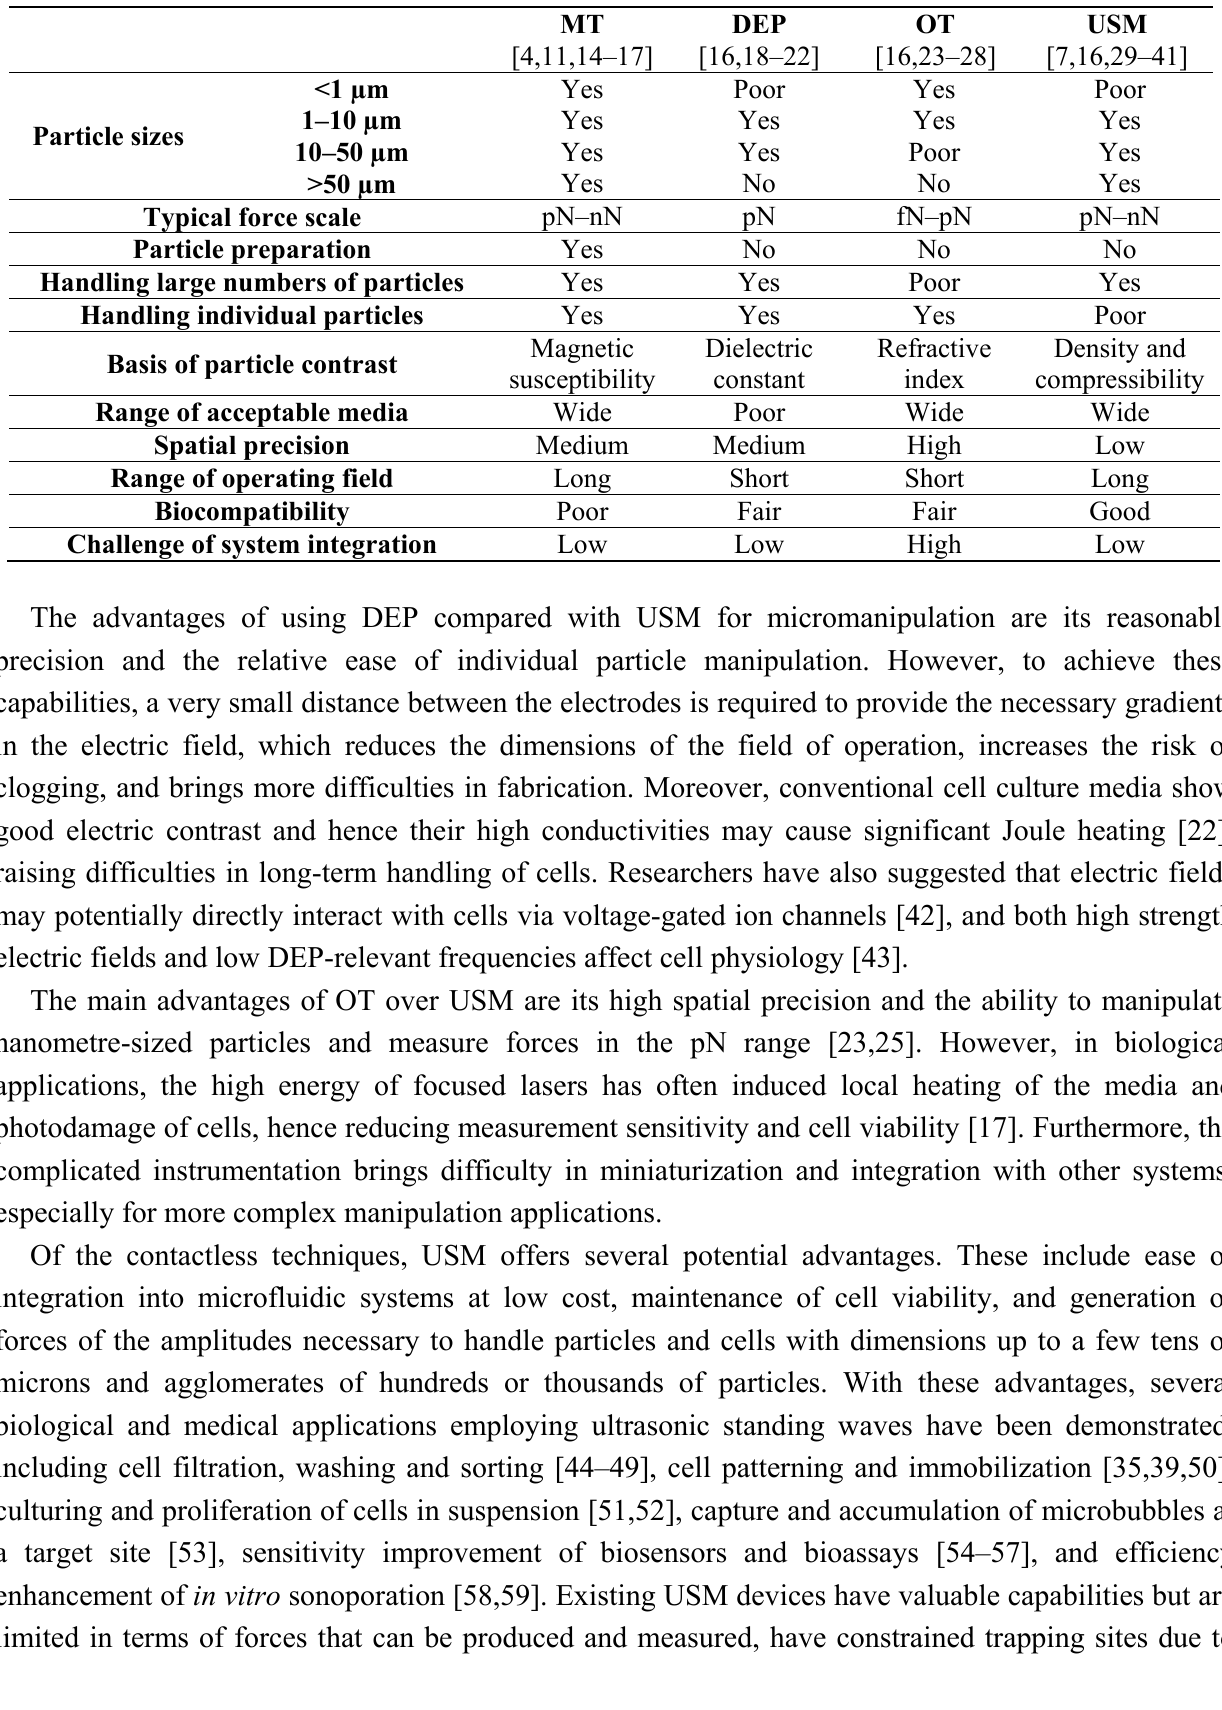
Table 1. Outline capabilities of important contactless micromanipulation